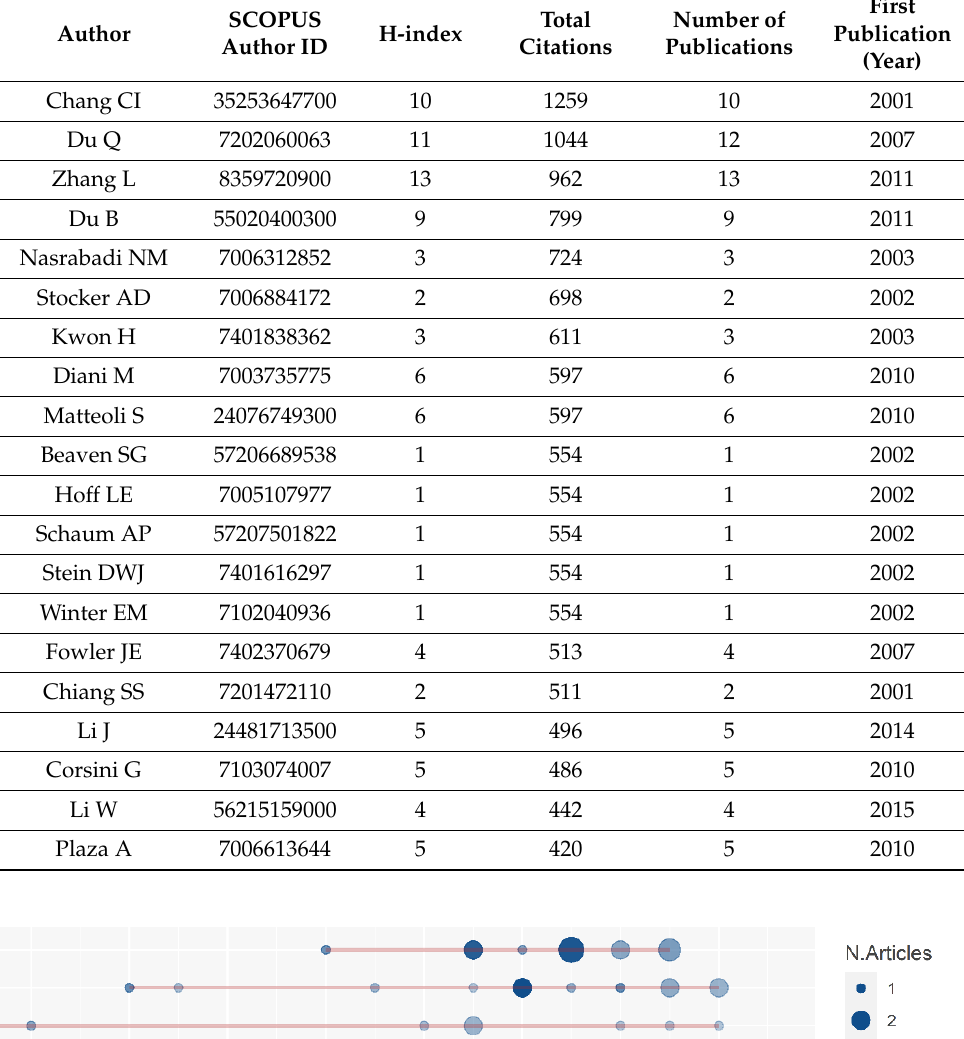
Table 3. The statistics of the 20 most relevant authors in the topic, sorted by total number of citations.